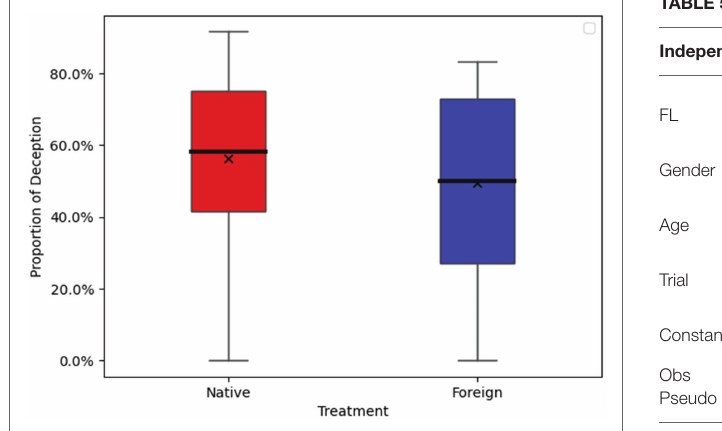
FIGURE 4 | Proportion of participant lying behaviour.